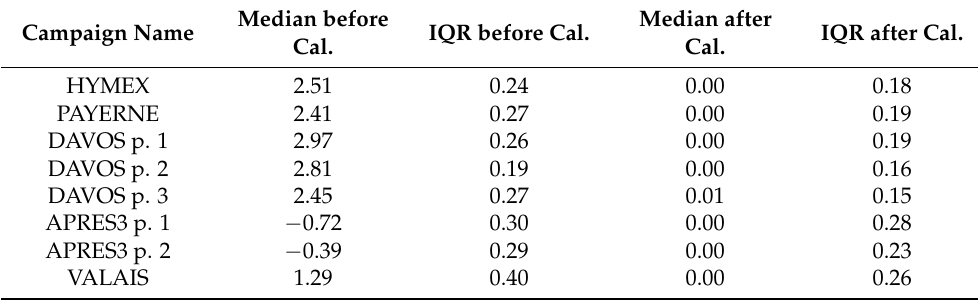
Figure 10. Histograms of the Z DR values from the homogeneous region selected in Section 3.1, before (in red) and after (in green) the calibration. Each histogram has been centered around its median value. Each panel refers to the campaign (or part of it) displayed in the title. Table 2. The median and interquartile range (IQR) of the empirical probability density function of the Z DR values before and after the calibration of the vertical PPI scans. All values are expressed in